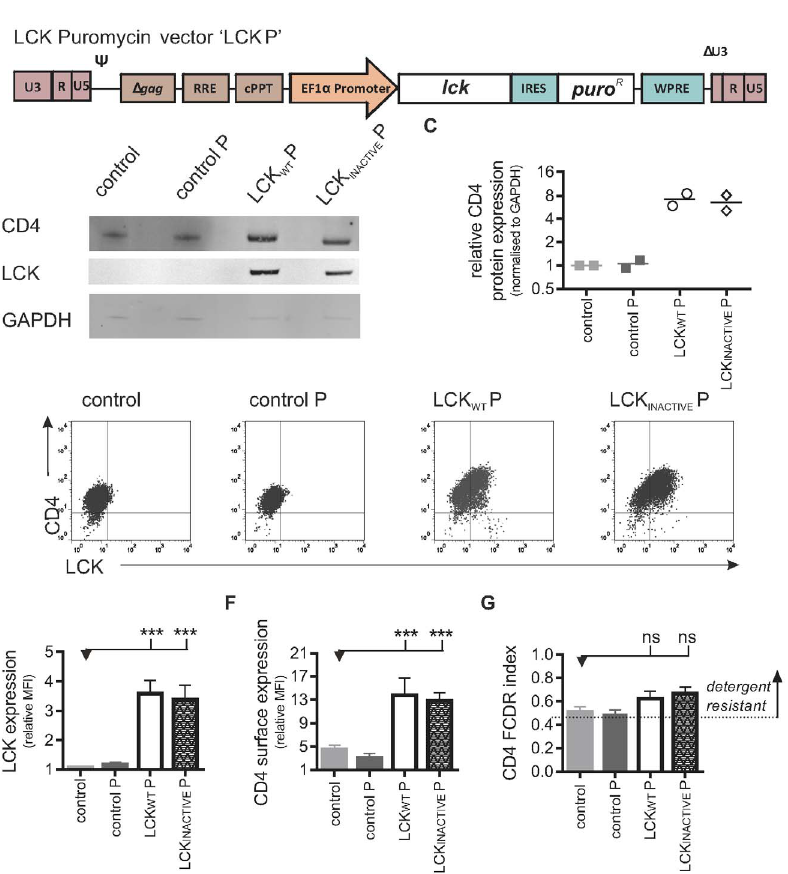
Figure 1. Higher levels of CD4 are found in macrophages expressing LCK. A) Schematic diagram of self-inactivating lentiviral construct used to express wild-type Lck and puro R (LCK WT P). A similar construct was used to express a kinase inactive form of Lck and puro R (LCK INACTIVE P) or to express puro R only (‘control P’). B) Detection of protein expression of LCK and CD4. Control and transgenic PSC-macrophages lysates were analysed by western blotting using anti-LCK and anti-CD4 antibodies. The loading control GAPDH was detected using anti-GAPDH antibody. C) Protein levels were measured with Odyssey software (Li-COR) and CD4 expression was normalised to GAPDH expression. Symbols represent normalised CD4 expression, relative to the PSC-macrophages control group, of two independent experiments. D) Detection of surface CD4 and total LCK expression. Representative two-colour immunofluorescence (dot plot) analysis is shown. Gates were determined by using the two relevant isotype control antibodies. Quantification of total LCK expression (E) and surface CD4 expression (F), expressed as the ratio of the geometric mean fluorescence intensity (MFI) over the isotype control 6 SEM of independent experiments (n=7). G) Detergent resistance of CD4, expressed as mean Flow Cytometric Detergent Resistance (FCDR) index of CD4 (n=4) in PSC-macrophages, calculated as described in materials and